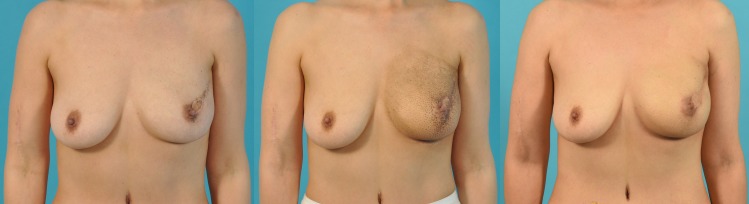
Photographic image of a patient.(A) 43-year old patient 4 weeks after nipple-sparing mastectomy and immediate breast reconstruction with a free transverse rectus abdominis flap. (B) After completion of adjuvant radiation therapy. (C) One year after the completion of radiation therapy. Increased symmetry and a decrease in the upper part of the reconstructed breast is observed.